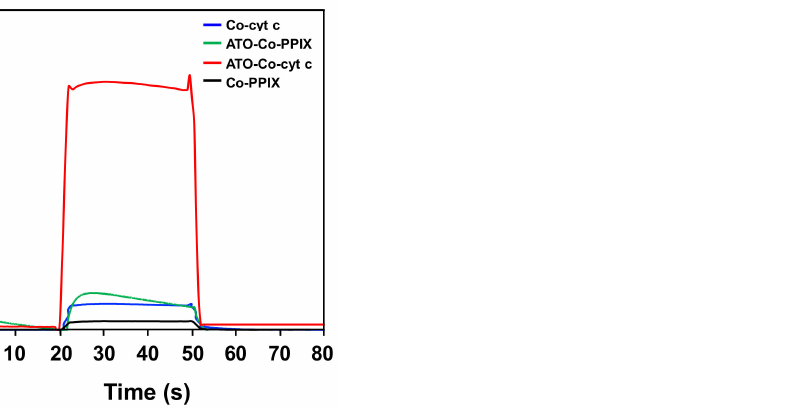
Figure 6. Light control photocurrent measurements in a three-electrode configuration in citrate buffer pH 5.0; applied bias 0.25 V vs. RHE, with a blue light source. 5 µ M Co-PPIX in solution (black), 5 µ M Co-cyt c in solution (blue), ATO-Co-PPIX (green), and ATO-Co-cytc